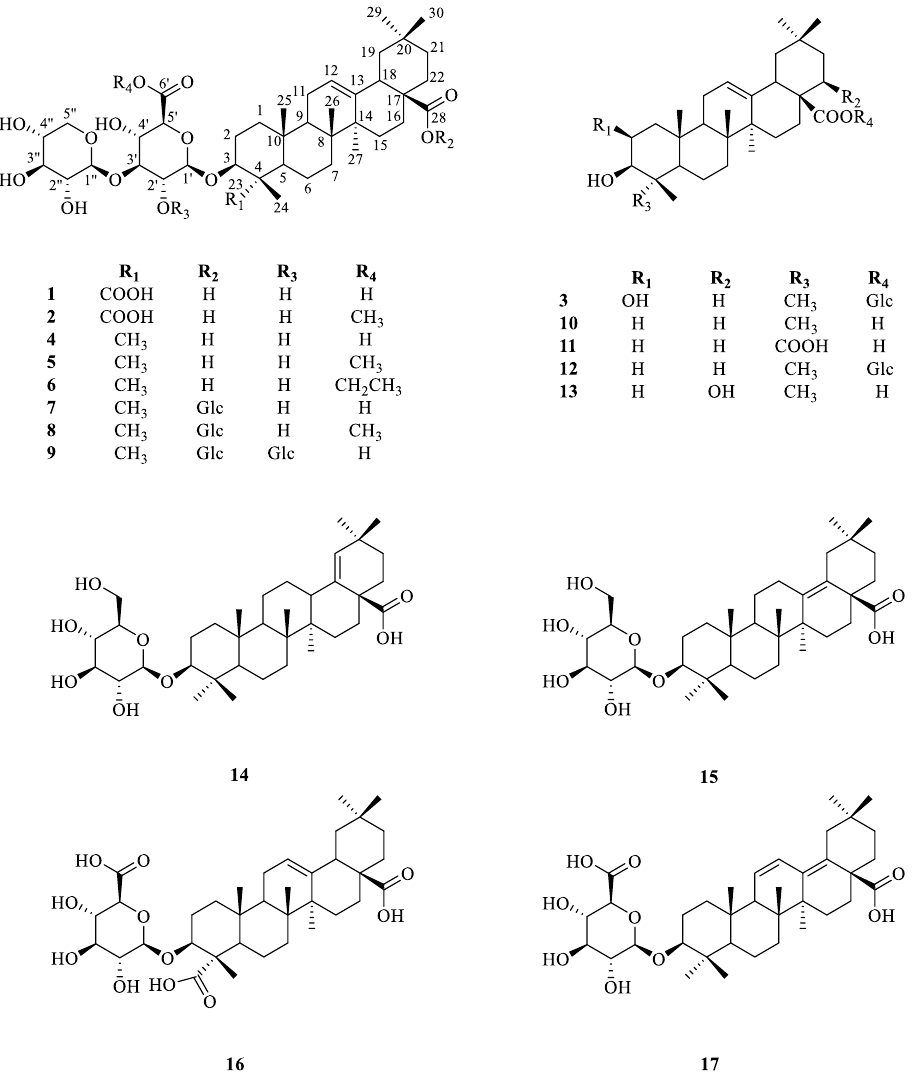
Figure 4. Chemical structures of compounds 1 − 17 isolated from Kochiae Fructus.